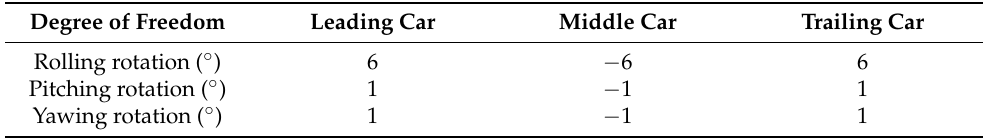
Figure 1. Geometric models employed in the numerical simulation: ( a ) the realistic CRH3 train; ( b ) the CAD model train; ( c ) front view of the train; ( d ) length components of the train; ( e ) train model with specific posture, according to Table 1. Table 1. Posture assigned to each